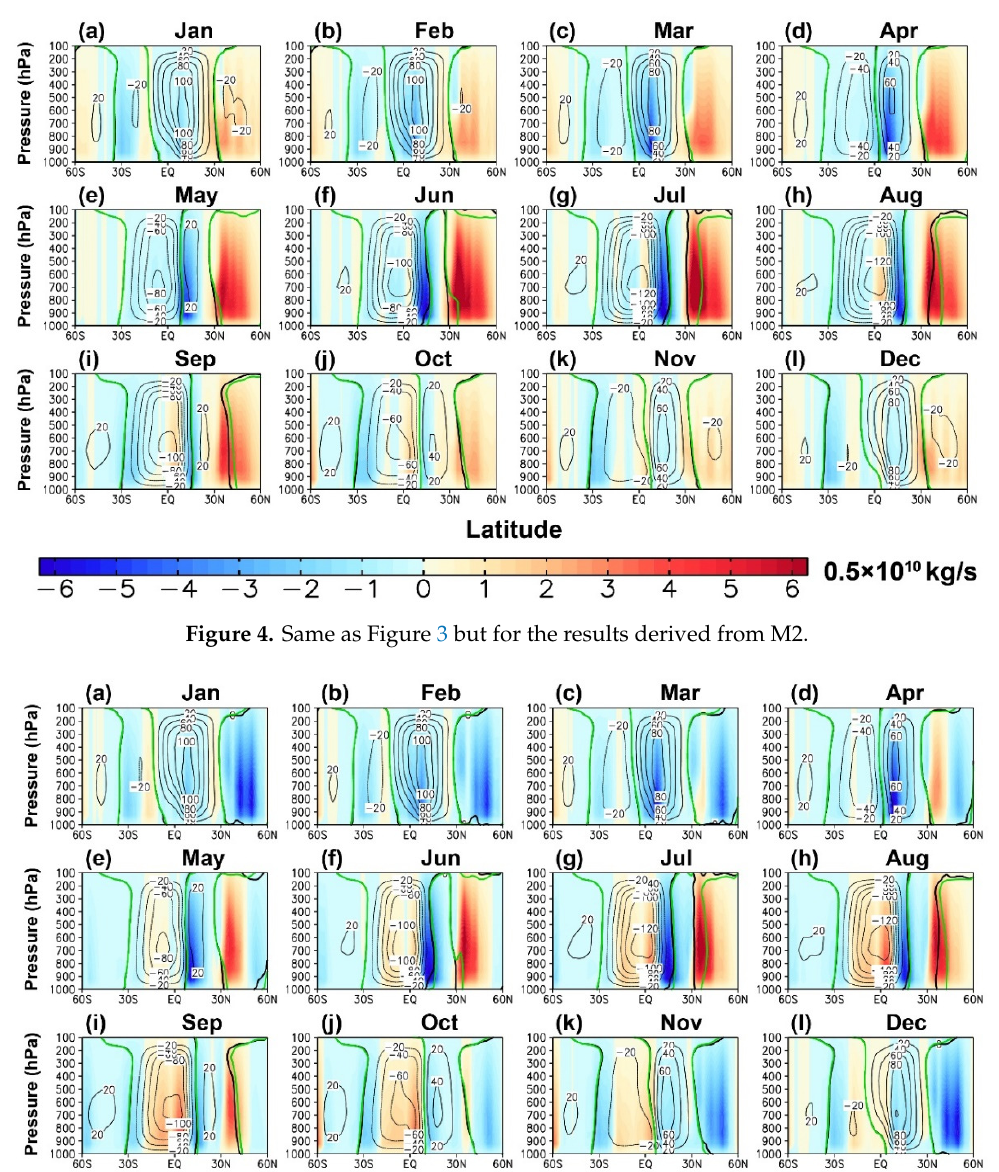
Figure 3. Black contours: mean state (1979–2018) of the HC between 60°S and 60°N represented by the MSF that considers FBGMW derived from M1 using the MRM data sets. Shading: difference between the uncorrected and corrected mean state of the HC. Green contours: same as black contours but for the zero lines of the MSF without considering FBGMW. The units for the MSF are 0.5 × 10 10 kg/s.